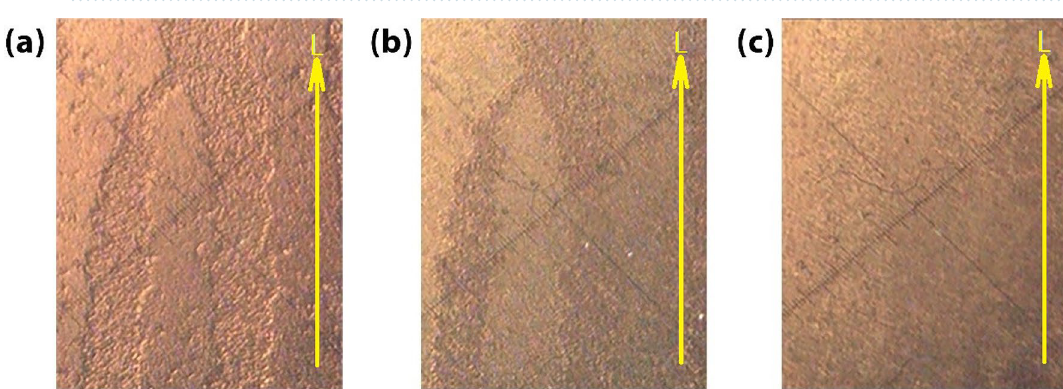
Figure 8. The surface morphology of the stored fork grating (singularity topological charge p = 1) in the sample is imaged using a polarizing microscope under ( a ) 0 v, ( b ) 3.9 v, and ( c ) 22 v applied